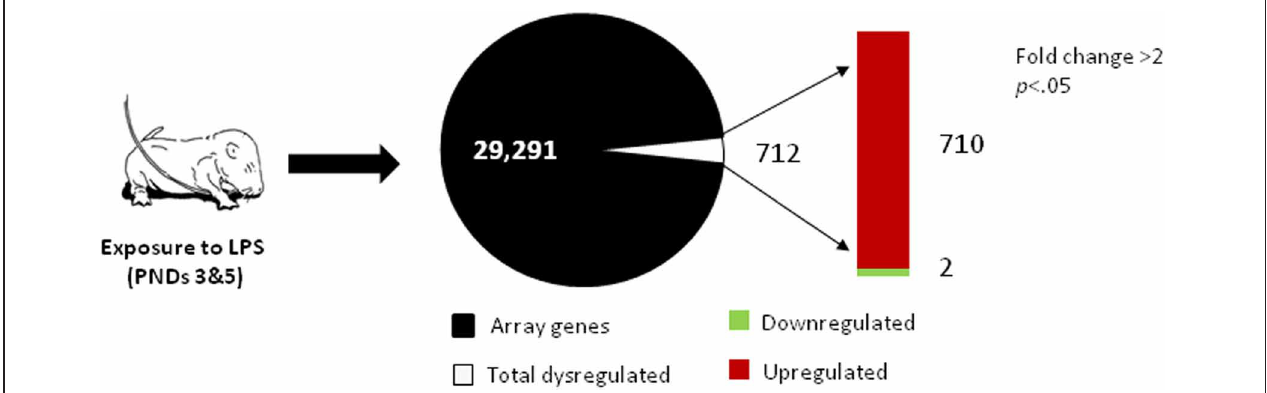
presented as non-regulated (black) and regulated (white) genes with a significant change in expression ( ≥ 2-fold change, p < 0 . 05). The red bar represents the number of upregulated genes and the green bar represents the number of downregulated genes in the ovaries of LPS-treated animals.